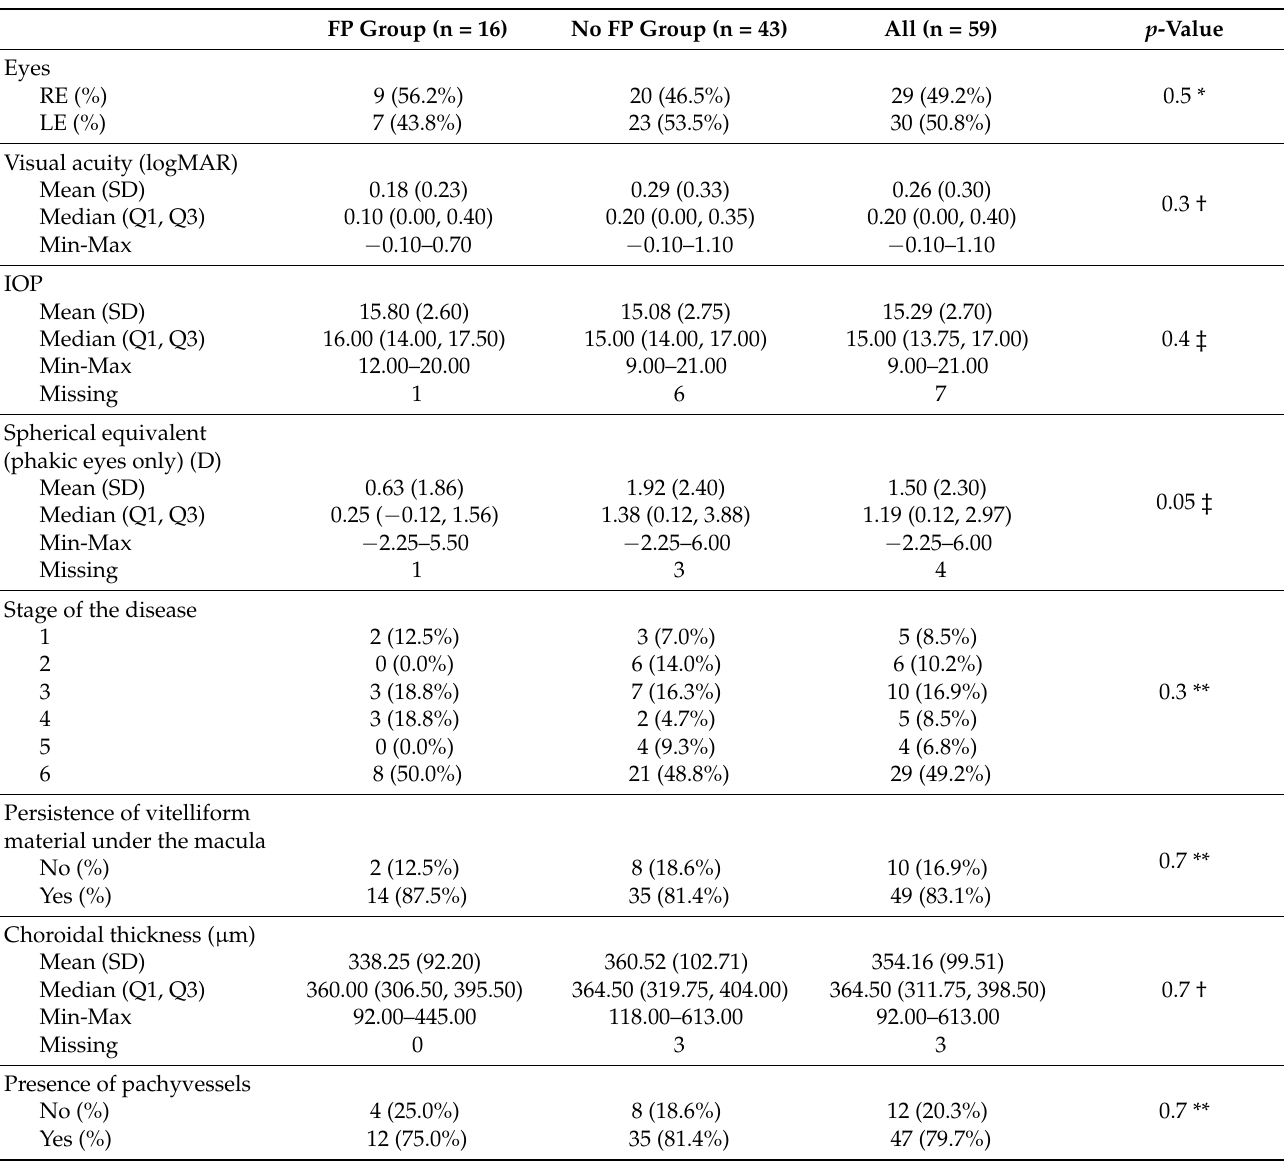
Table 3. Clinical and OCT characteristics of patients, according to the appearance of the